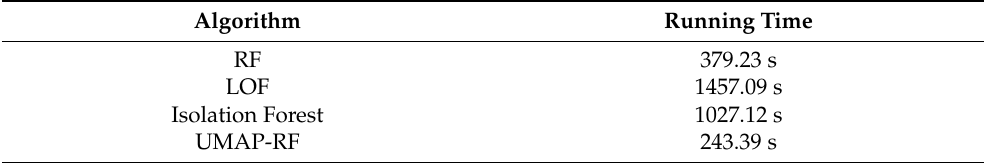
Table 5. Running time comparison of different